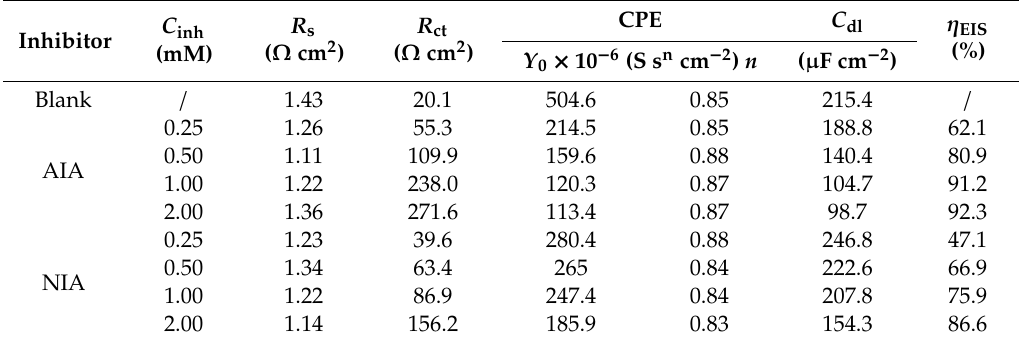
Figure 3. Electrical equivalent circuit used to fit the electrochemical impedance spectroscopy (EIS) experimental data. CPE: constant phase element. Table 1. Impedance data for Q235 steel in 1 M HCl with various concentrations of NIA and AIA at 298